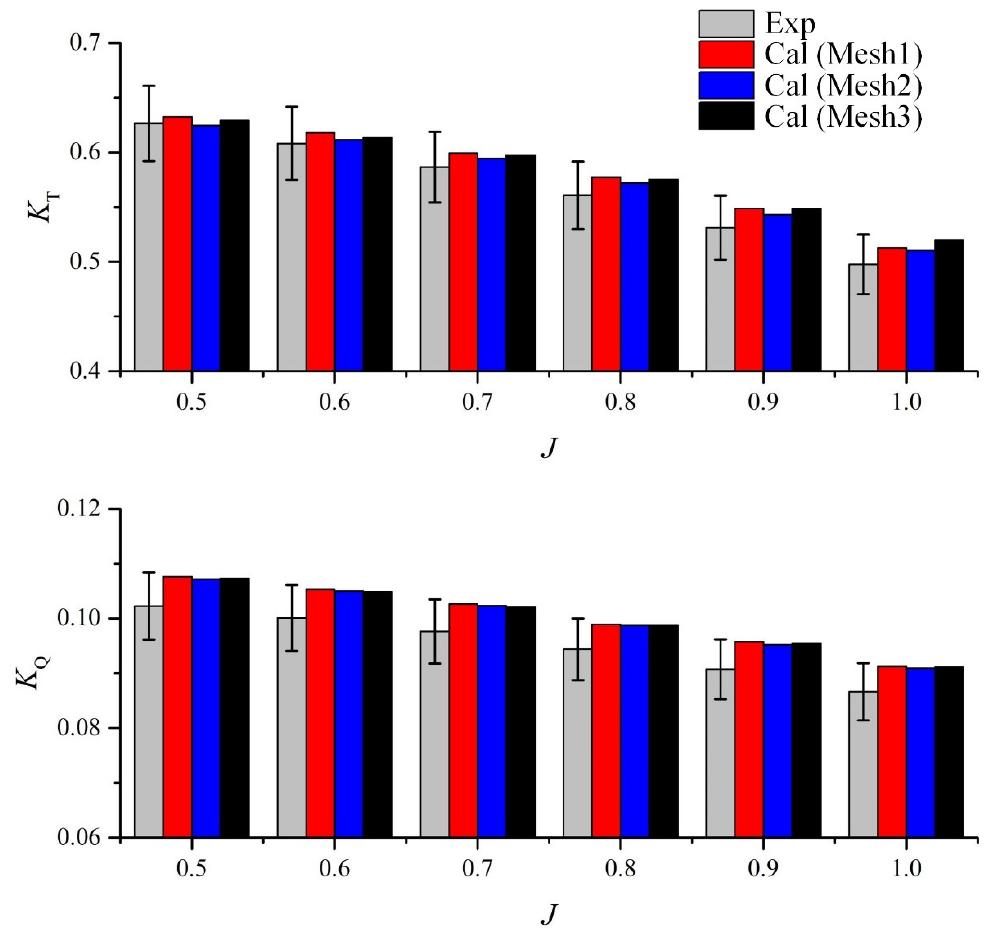
Figure 3. Measured [33] and calculated thrust coefficients K T and torque coefficients K Q for the waterjet pump.